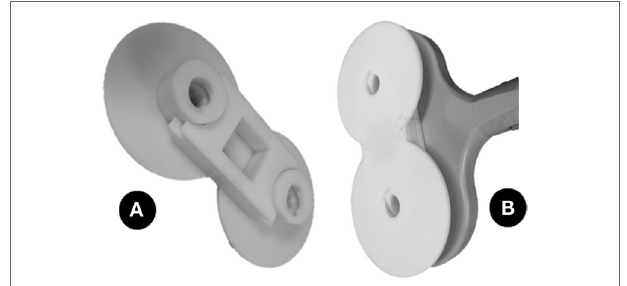
FigUre 3 | (a) The photo shows the prop used in the control condition. It is designed to mimic the texture and size of the TMS coil, but when applied to the coil (B) , it separates the coil from the head by 20 mm, thus preventing the appearance of